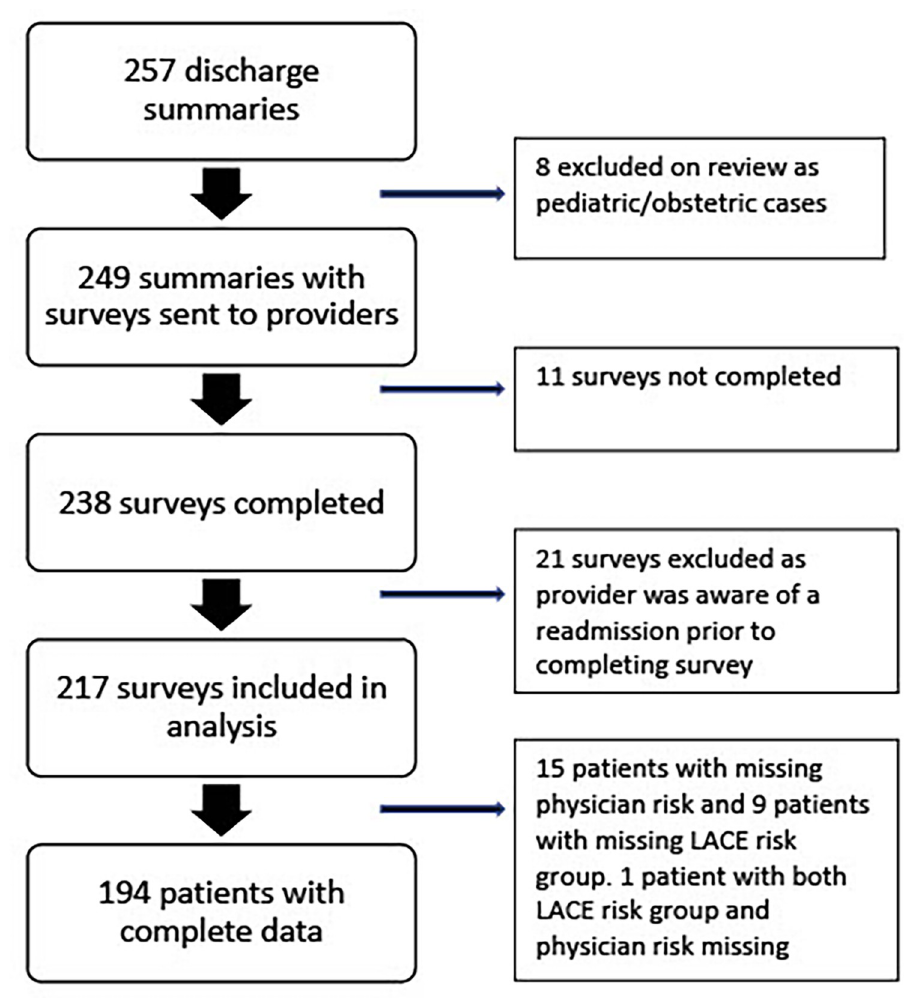
Fig 1. Number of patients included in the study.